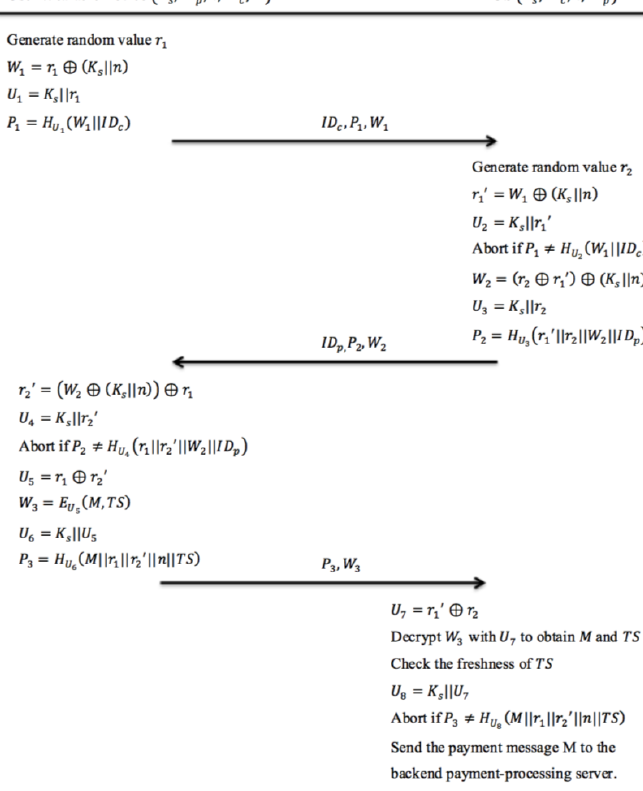
Figure 5. The proposed authentication protocol for BLE-based mobile payment system.